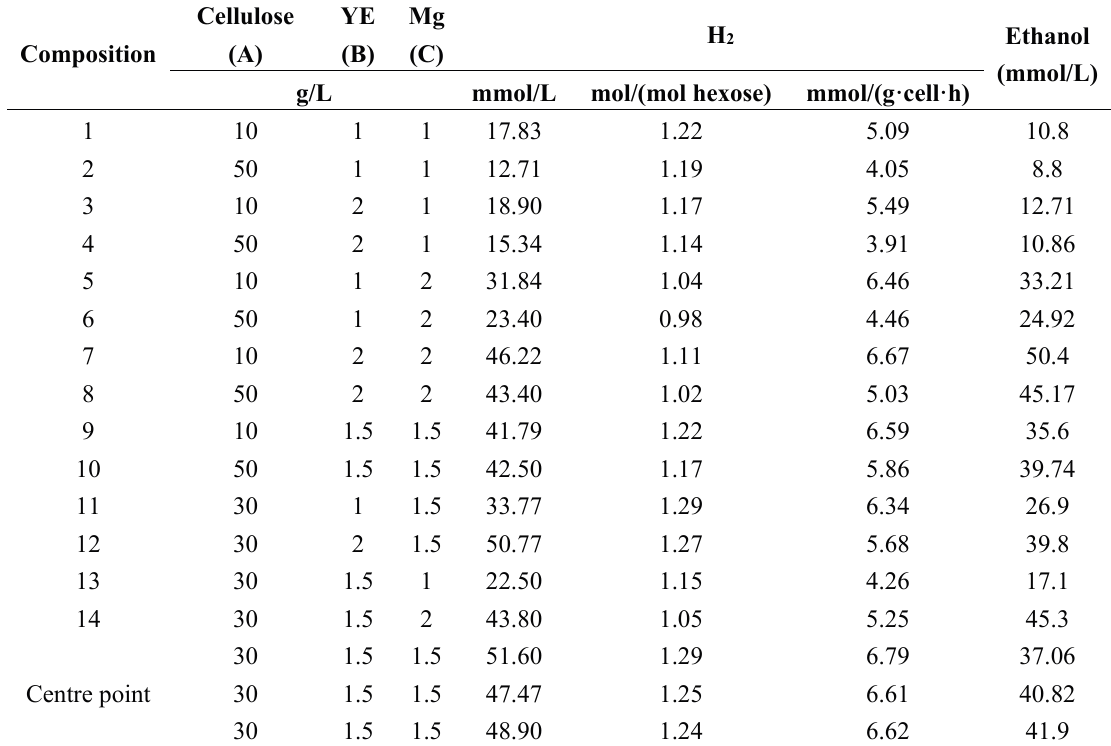
Table 1. Design matrix of the central composite face-centered design with measured responses for H 2 and ethanol. These data represent averages obtained from biological replicates. Composition